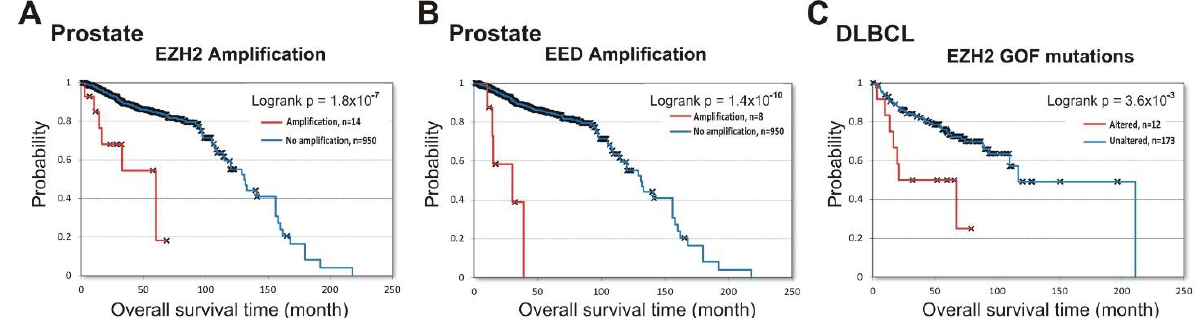
Figure 3. Alterations in PRC2 subunits at DNA level correlate with shorter patient survival in prostate cancer (EZH2 and EED) and DLBCL (EZH2). Analysis of correlation between alterations in DNA with patient survival was performed using cBioPortal. ( A ) Correlation between the overall survival and amplification of the EZH2 gene in prostate cancer. The amplification (red) vs. unaltered group (blue) is shown. ( B ) Correlation between the overall survival and amplification of the EED gene in prostate cancer. ( C ) Correlation between the overall survival and the presence of EZH2 GOF mutations in DLBCL. The group with EZH2 GOF mutation (red) vs. unaltered group (blue) is shown.